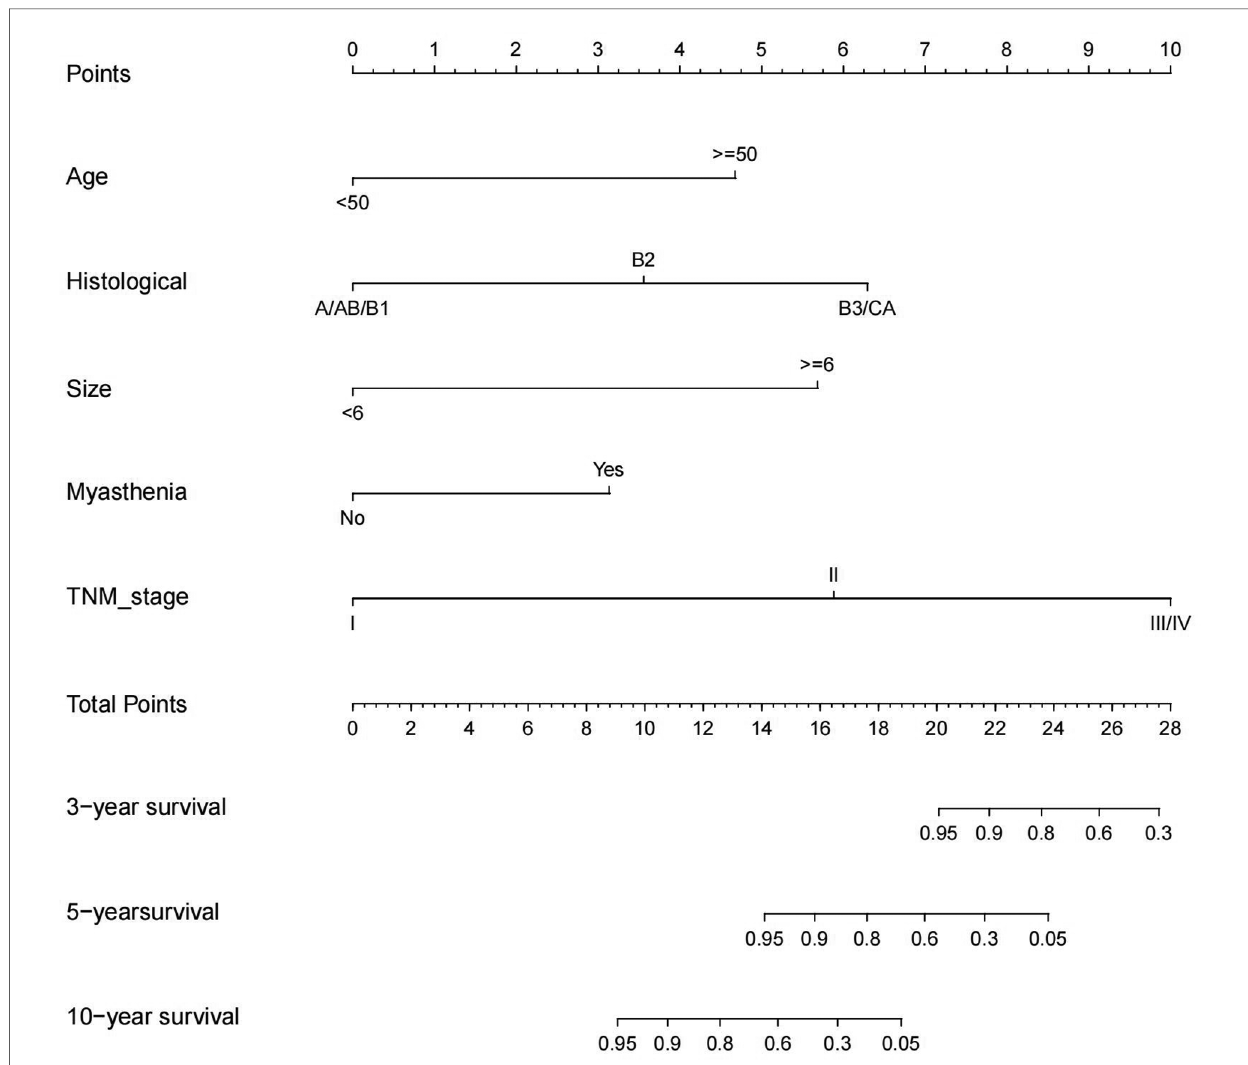
FIGURE 3 Competing risk nomogram for the prediction of 3-, 5-, 10-year cause-speci fi c survival associated with